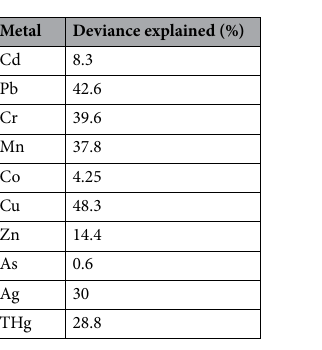
Table 4. Deviance explained (%) by generalized additive models between size and metal concentrations for Caribbean Reef